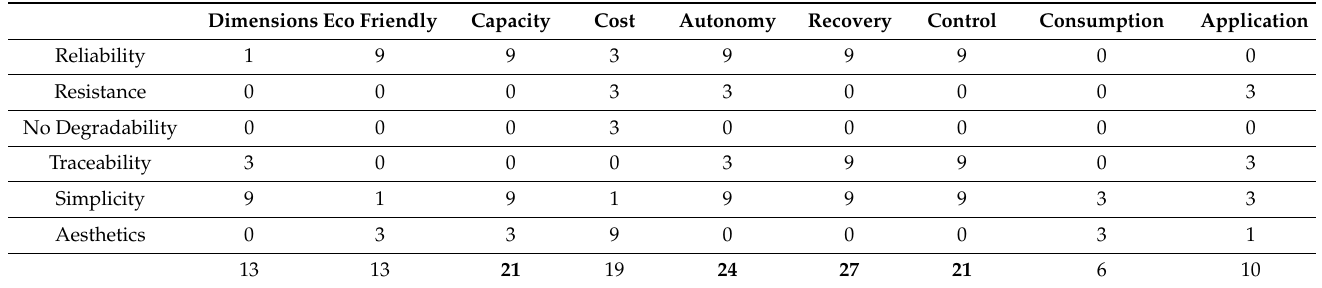
Table 5. What–How